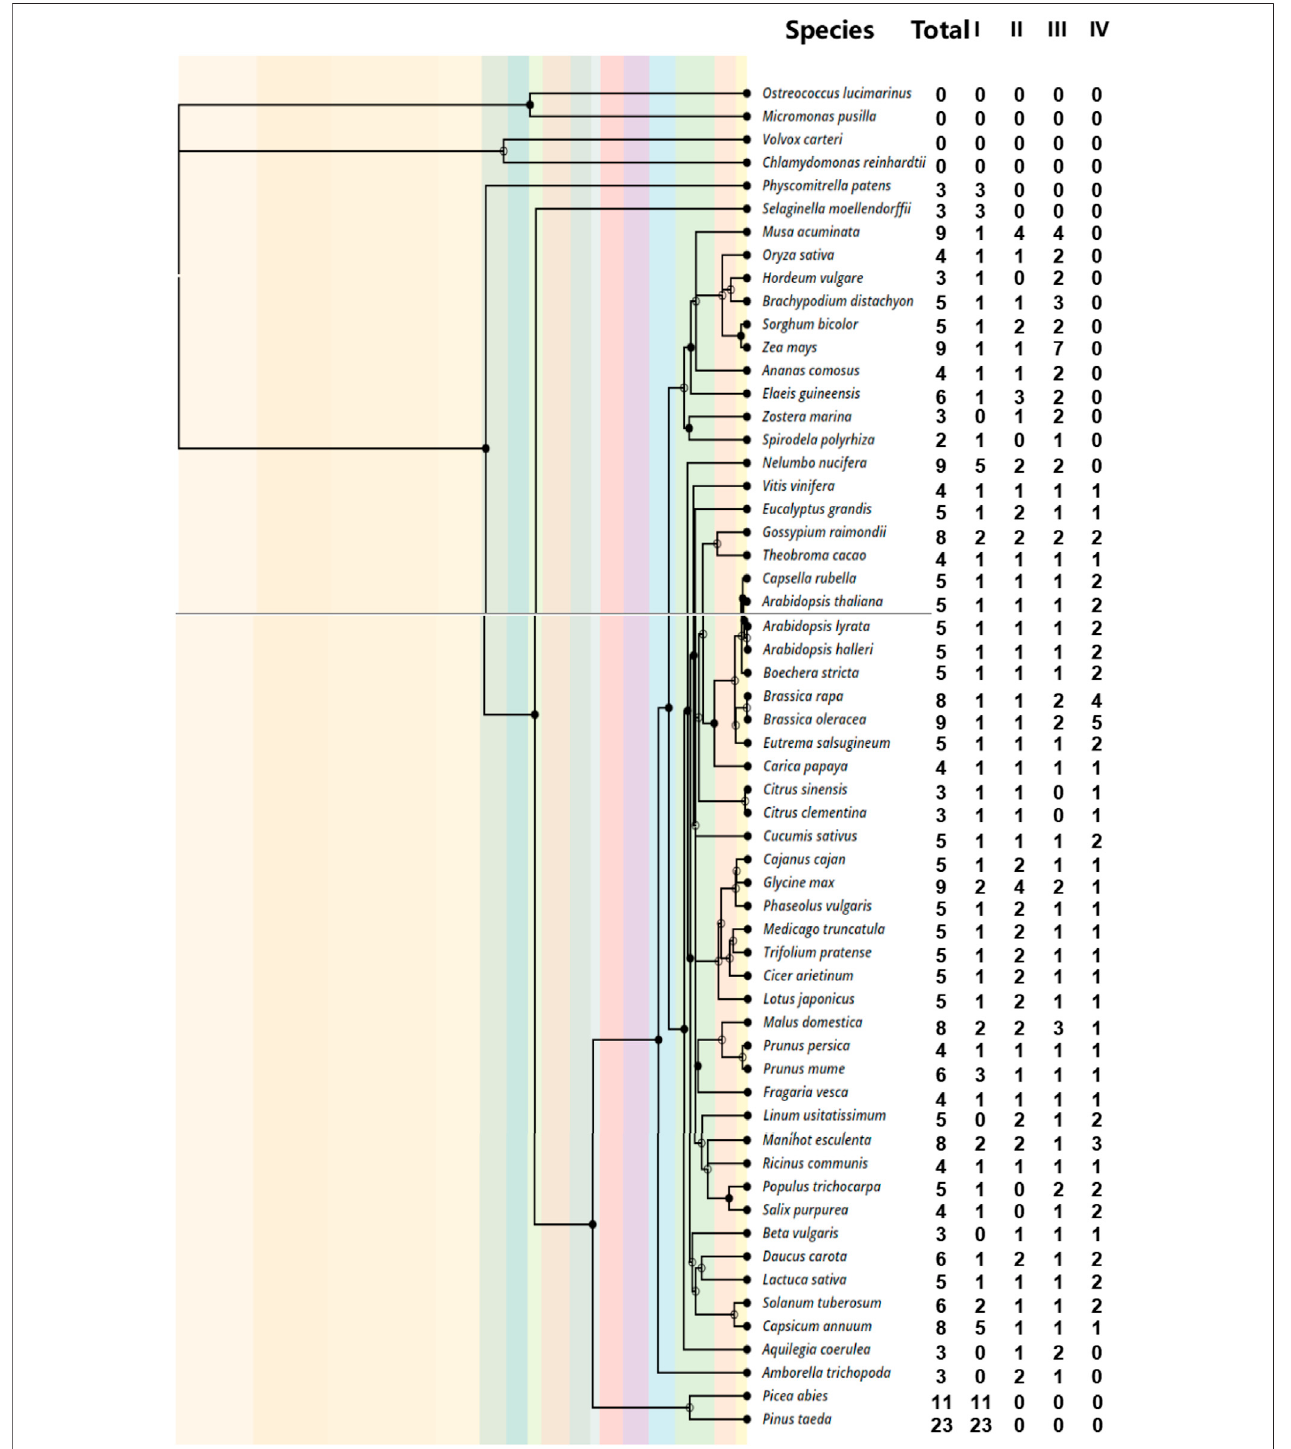
FIGURE 1 | The phylogeny of the 58 plants analyzed in this study and the number of DUF1005 genes identi fi ed. The order of tree branches and divergence time was derived from the TimeTree database (http://timetree.org/).